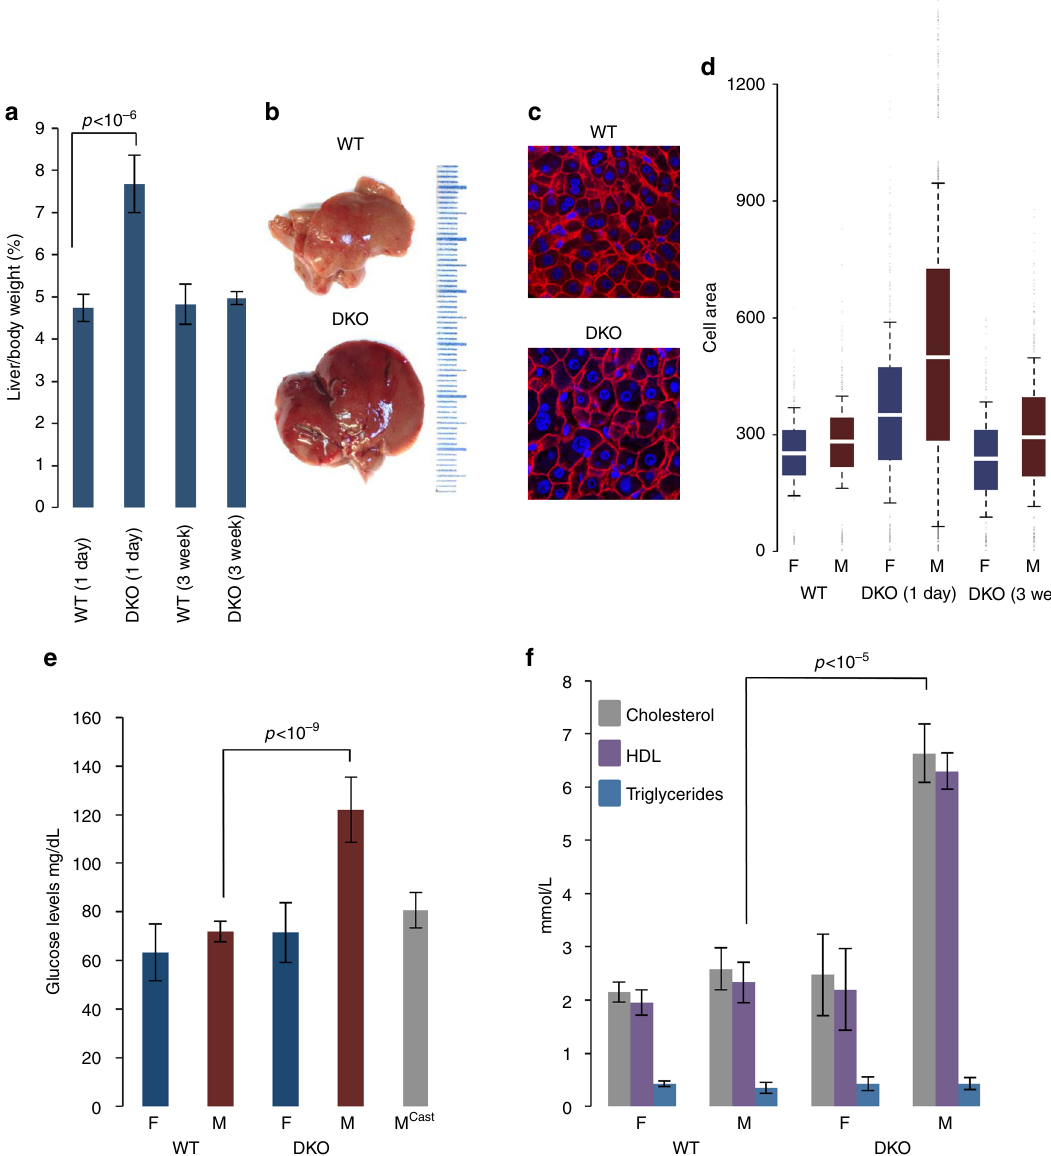
Fig. 5 Effect of Tet2/Tet3 de fi ciency on liver function. a Liver to body weight ratio (±s.d.) in 15-week-old WT and DKO mice induced at 1 day or 3 weeks. b WT and DKO (1 day) liver. c E-cadherin staining of sections from 15-week-old WT and DKO mice induced at 1 week. d Box plot of hepatocyte cell size ( μ 2 ) based on E-cadherin staining in 15-week-old WT and DKO male (M) and female (F) mice induced at 1 day or 3 weeks. e Serum glucose or f cholesterol, HDL, and triglyceride levels (±s.d.) of 15-week-old WT and DKO mice. Results are also shown for DKO males castrated at 3 weeks (M Cast